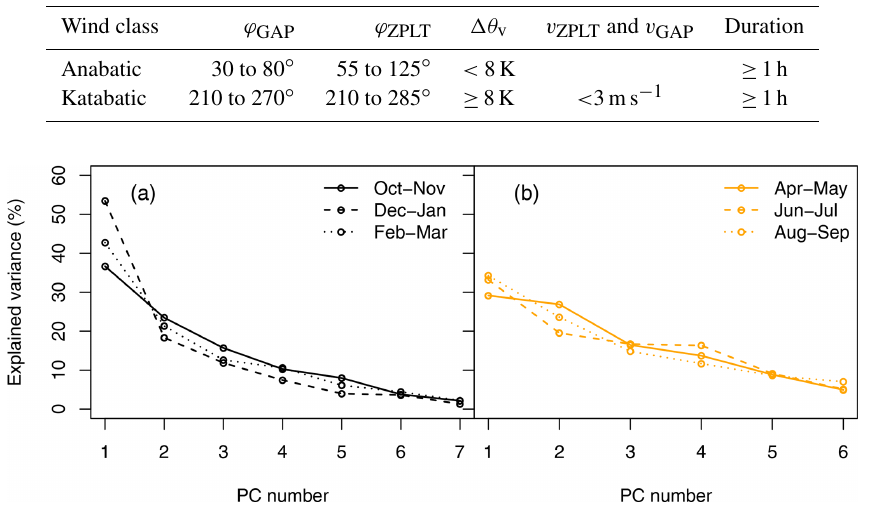
Table 2. Criteria for thermally induced anabatic and katabatic winds occurring simultaneously at GAP and ZPLT. ϕ is wind direction, v is wind velocity, and (cid:49)θ v is the range of the pseudo-vertical profile of virtual potential temperature.